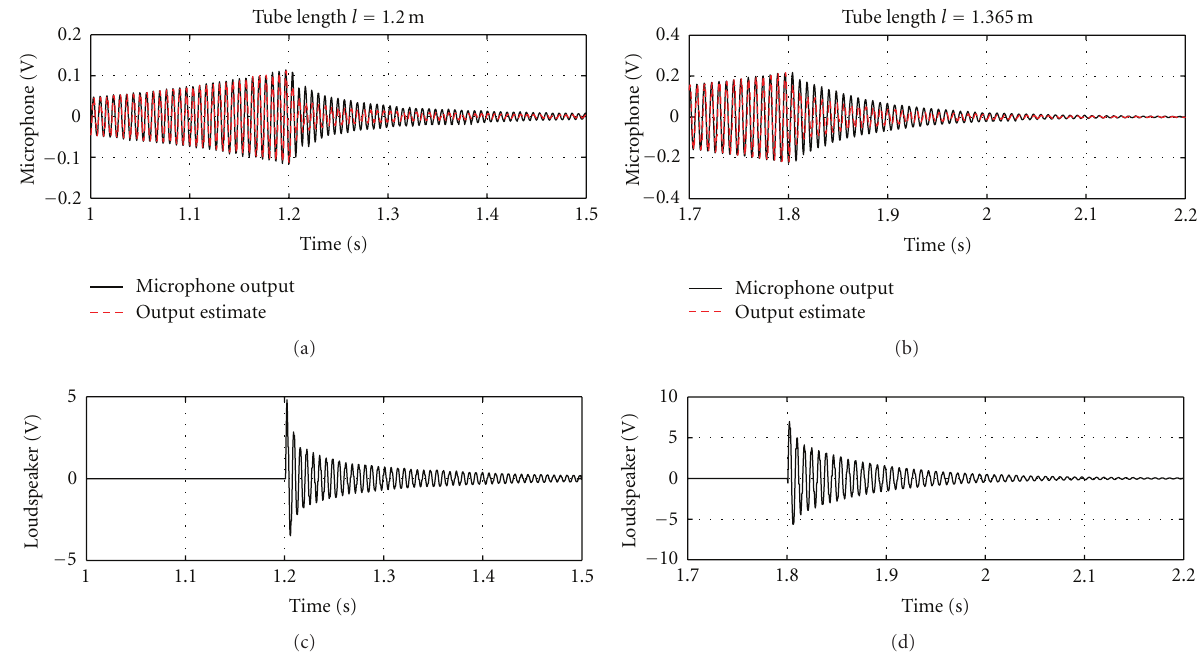
Figure 6: RMPC of the unstable Rijke tube with di ff erent length in the experiment. The RMPC has a prediction horizon of N = 4 and uses a robust state observer. The maximum calculation time for l = 1 . 2m is 3 . 35 × 10 − 5 s and for l = 1 . 365m1 . 9 × 10 − 4